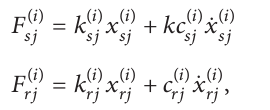
Based on the parameters listed in Tables 1, 2, and 3, vibration displacement can be obtained by solving the electromechan- ical coupling model. As shown and discussed above, torque ripple of inverter motor is unavoidable and may influence the dynamic response of gear transmission system. Therefore, vibration displacements under electromagnetic torque 𝑇 𝑒 with ripple and idealized piecewise torque without ripple are calculated